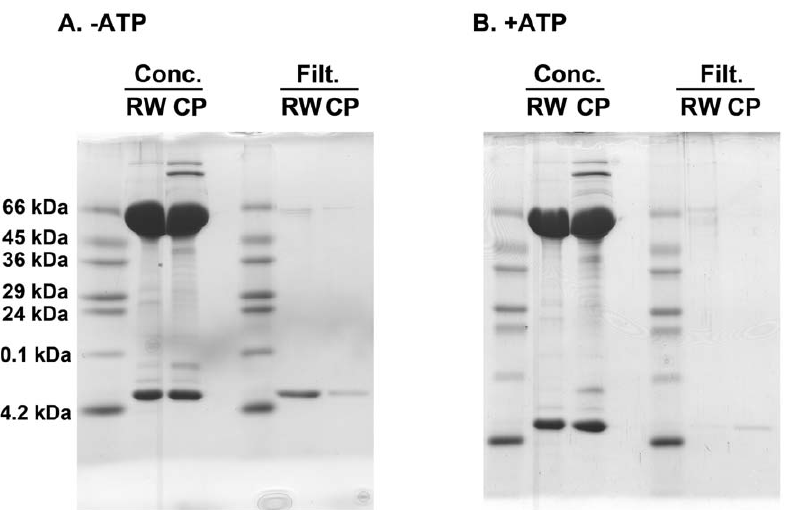
Figure 7. Relative stability of the GroEL-ADP-GroES complexes formed at 37 6 C. Each GroEL sample was incubated for 2 h at 37 u C with an equimolar concentration of GroES. After incubation, samples were partitioned by centrifugal concentration (100 kDa cutoff). Samples denoted "Conc." indicate a 24 m g aliquot of each sample recovered from the upper reservoir concentrate of the filtering apparatus. Samples denoted "Filt." represent proteins that were recovered from a 200 m l aliquot of the lower reservoir filtrate of the apparatus. Experiments were performed in the absence ( 2 ATP, A ) and presence ( + ATP, B ) of 0.2 mM ATP. RW indicates GroEL R231W, and CP indicates GroEL CP376-RW samples. The apparent molecular weights of a commercial marker mixture (Dalton VII molecular weight marker, Sigma) are indicated to the left of the figure.